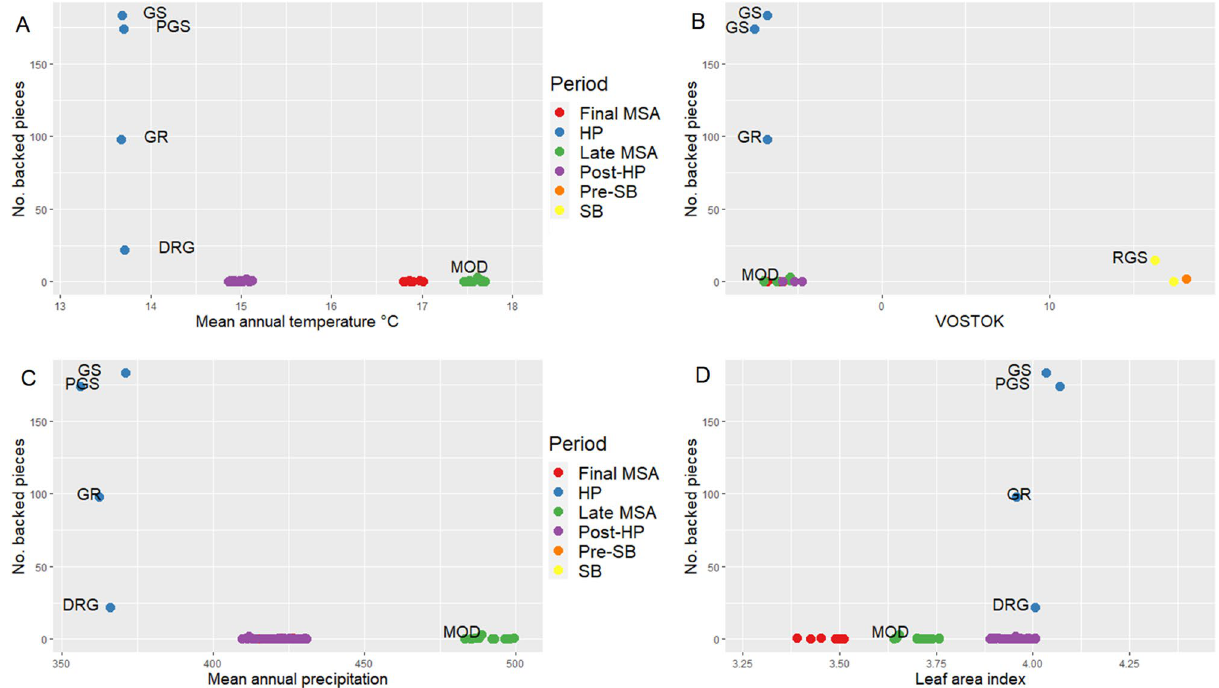
Figure 6. Scatter dot plots comparing the number of backed artifacts by technological group with ( A ) Mean annual temperature (minimum) (Sibudu). ( B ) Vostok global temperatures. ( C ) Mean Annual Precipitation (minimum) (Sibudu). ( D ) Leaf area index (Sibudu). Data for Sibudu from 29 . Data from MD02-2094 from 30 . This figure was created in RStudio 1.4 www. rstud io. com by